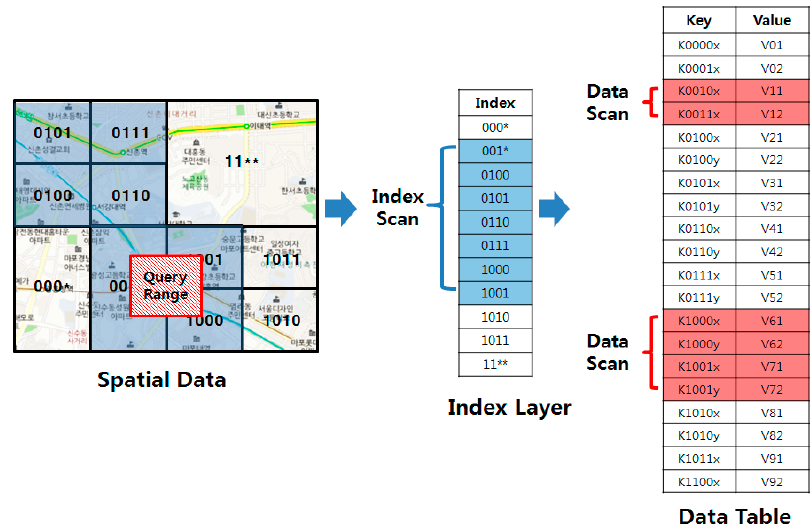
Figure 2. Range query processing using an indexing layer.